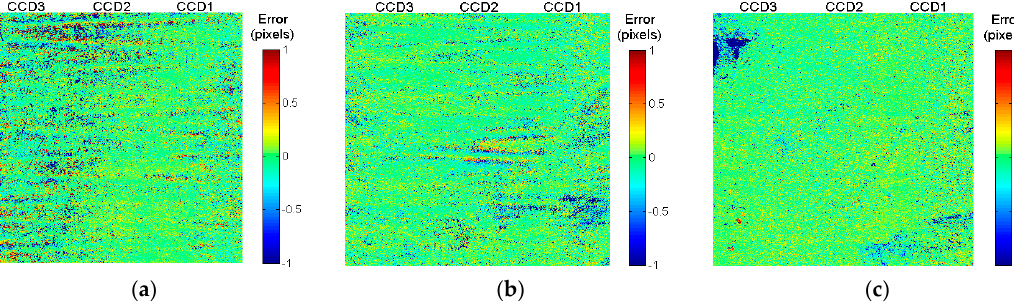
( c ) Figure 11. Relative time-varying errors across the track between B1 and B2 of ( a ) Scene A, ( b ) Scene B, and ( c ) Scene C using refined parallax images. Table 4. Detected results using B1–B2 images. Image ID